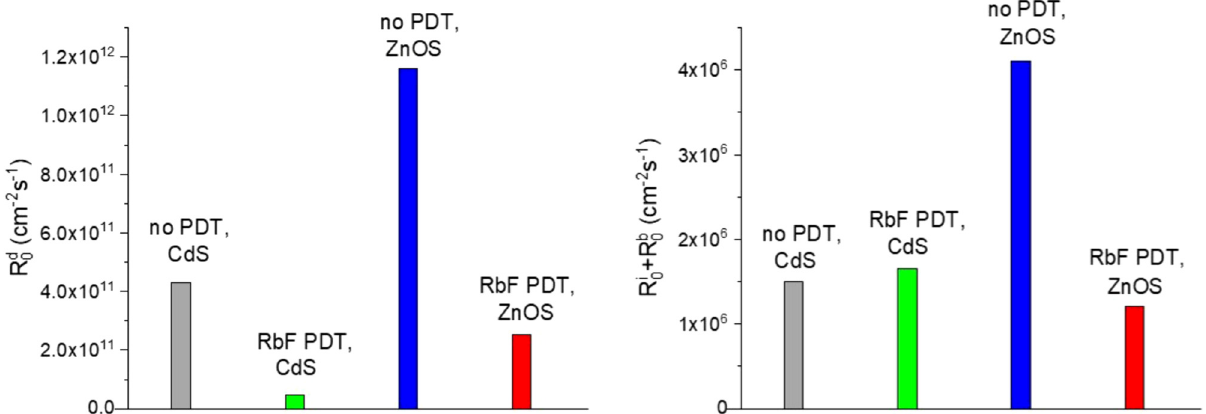
Fig. 5. Calculated recombination coef fi cients based on Grover-Li method for the four different types of cells.